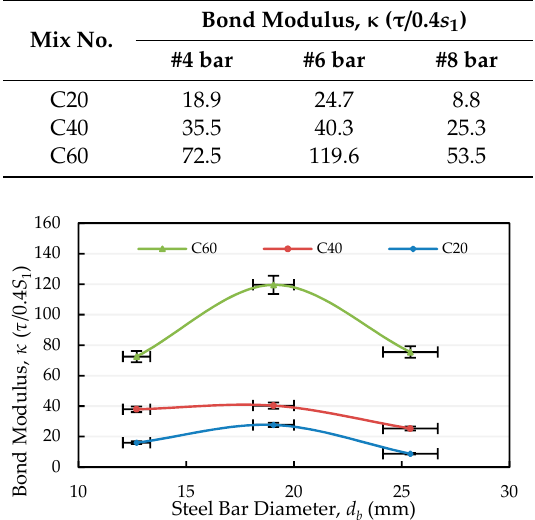
Figure 20. Comparison of the bond modulus under the same concrete compressive strength.